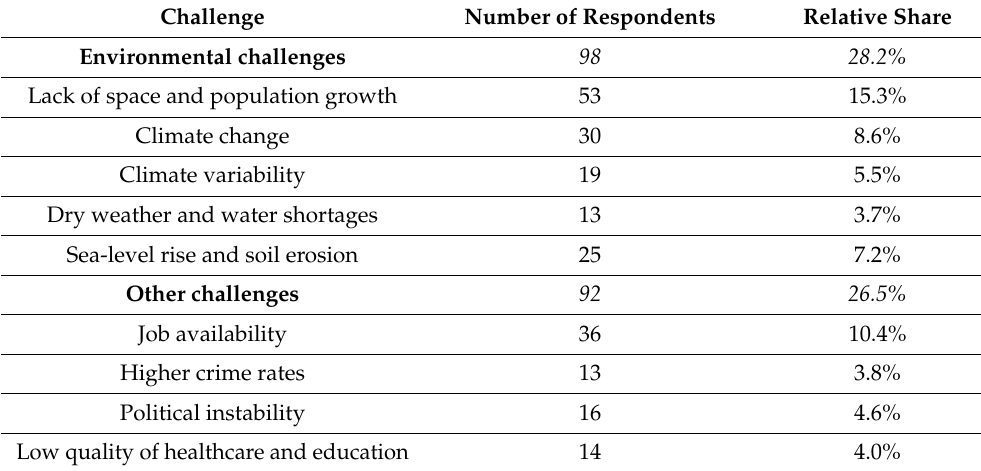
Table 4. Respondents’ perceptions of challenges in Mal é